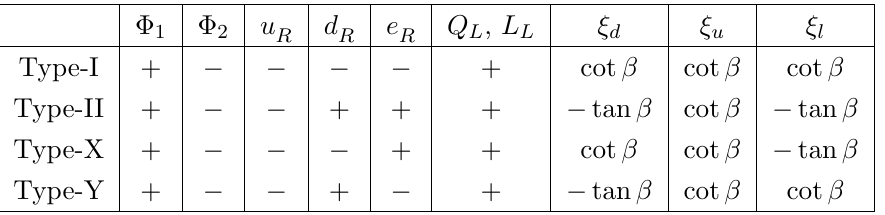
Table 1 . Z 2 charge assignment and (cid:24) -coe(cid:14)cients in the Yukawa couplings of d; u; l fermions in the four types of Yukawa